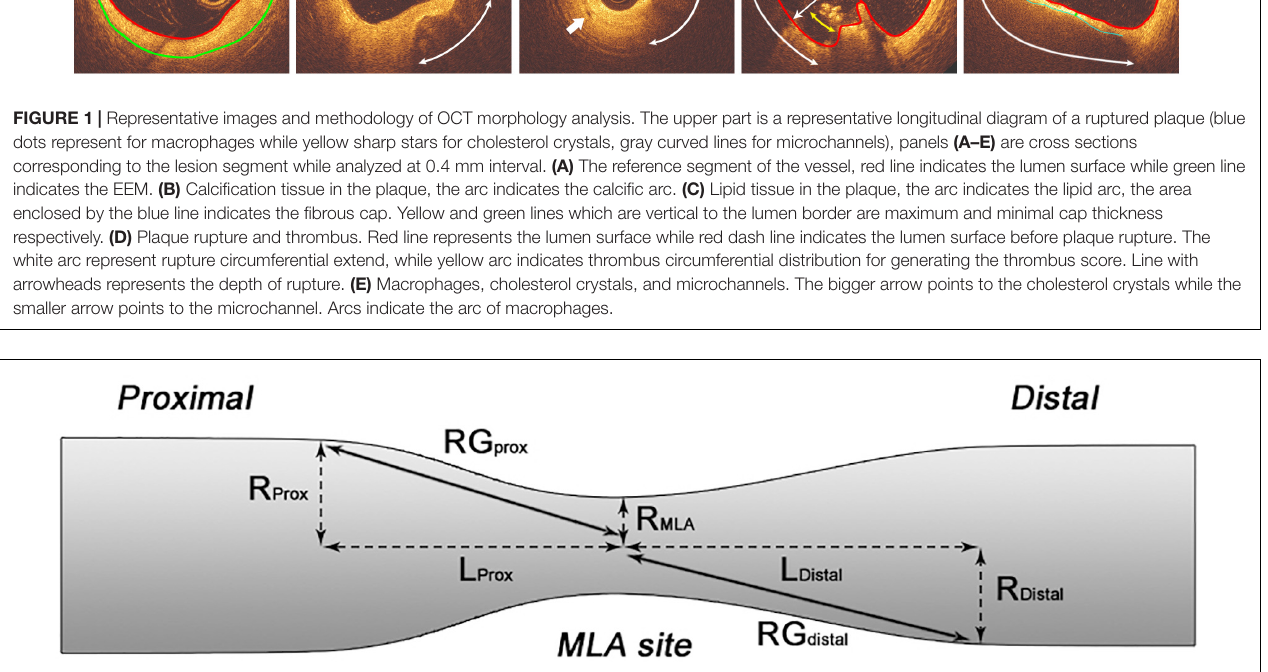
FIGURE 2 | Schematic diagram showing the calculation of RG RG prox = (R Prox -R MLA )/L Prox while RG distal = (R Distal -R MLA )/L Distal